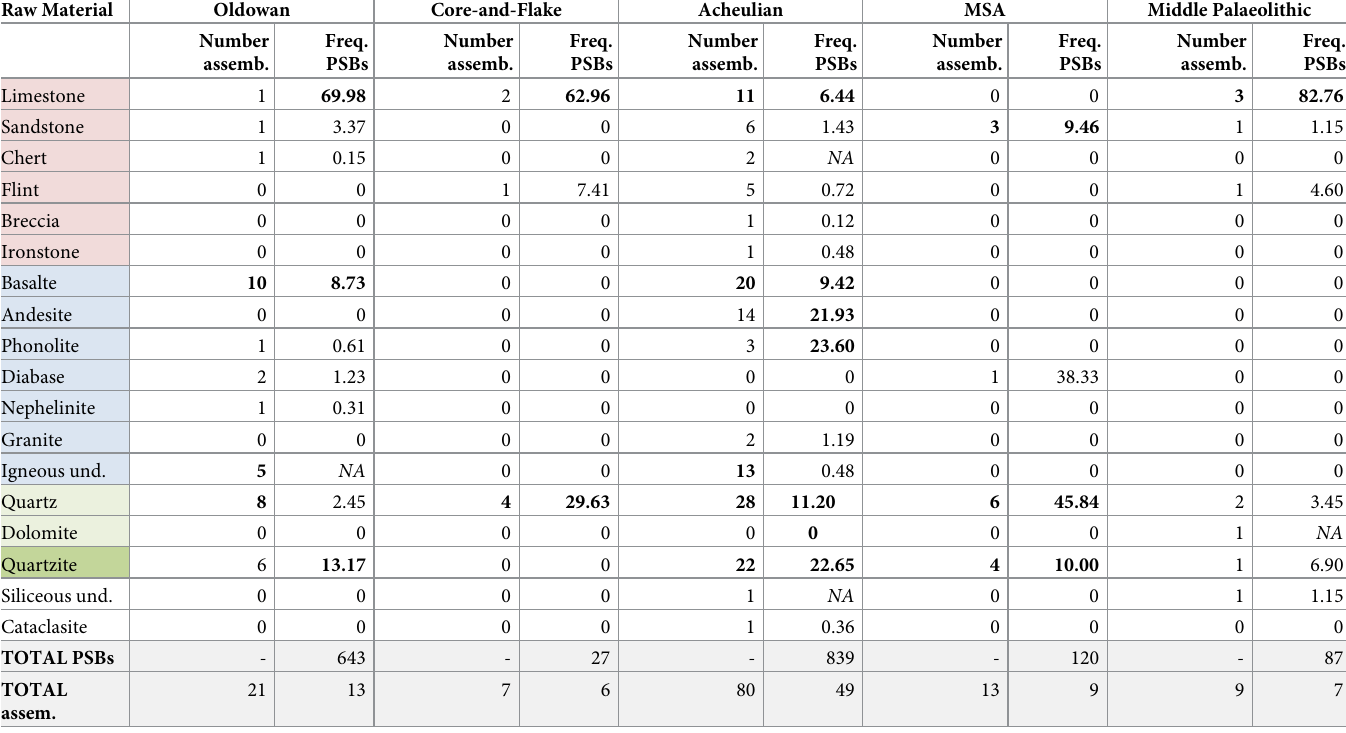
Table 4. Minimum numbers of assemblages with at least one PSB in the raw material of interest, and frequencies of PSBs according to raw materials and chrono- cultural attributions. Raw Material Oldowan